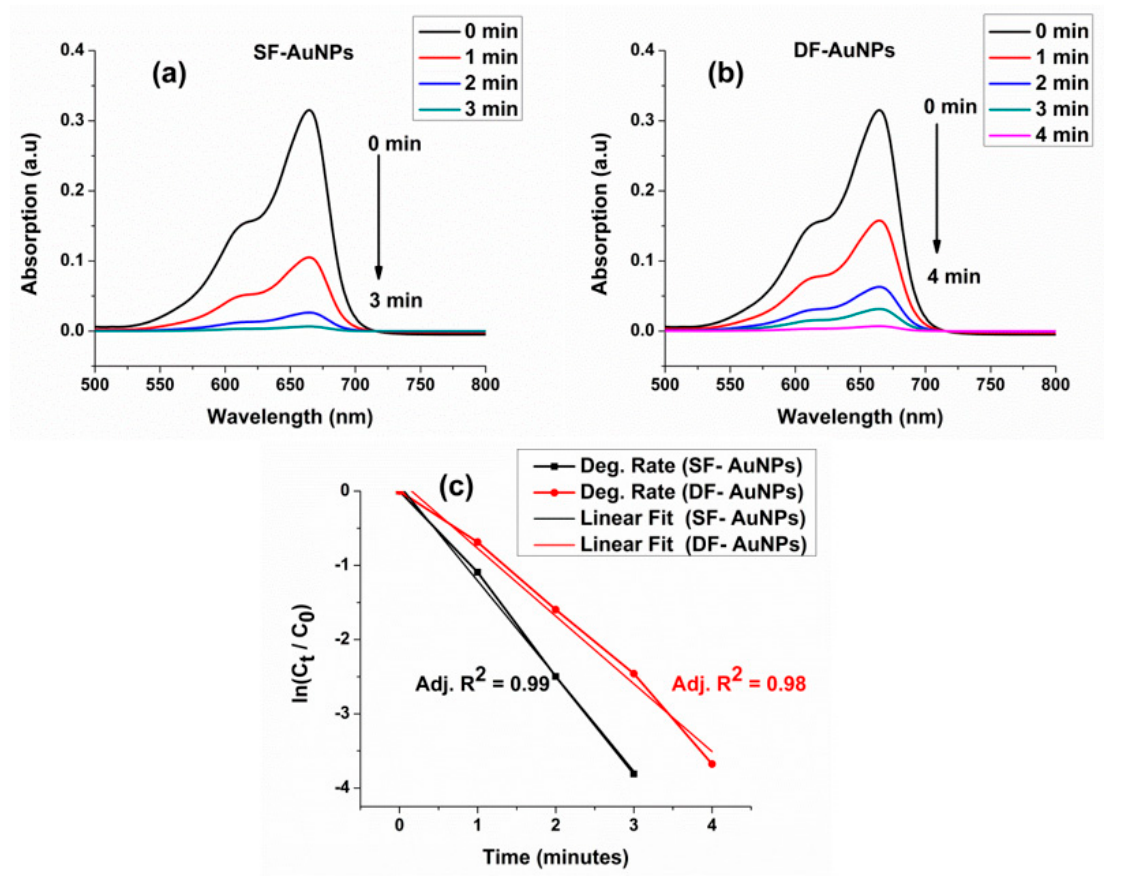
Figure 7. Catalytic degradation of MB by ( a ) SF-AuNPs, ( b ) DF-AuNPs, and ( c ) degradation rates.